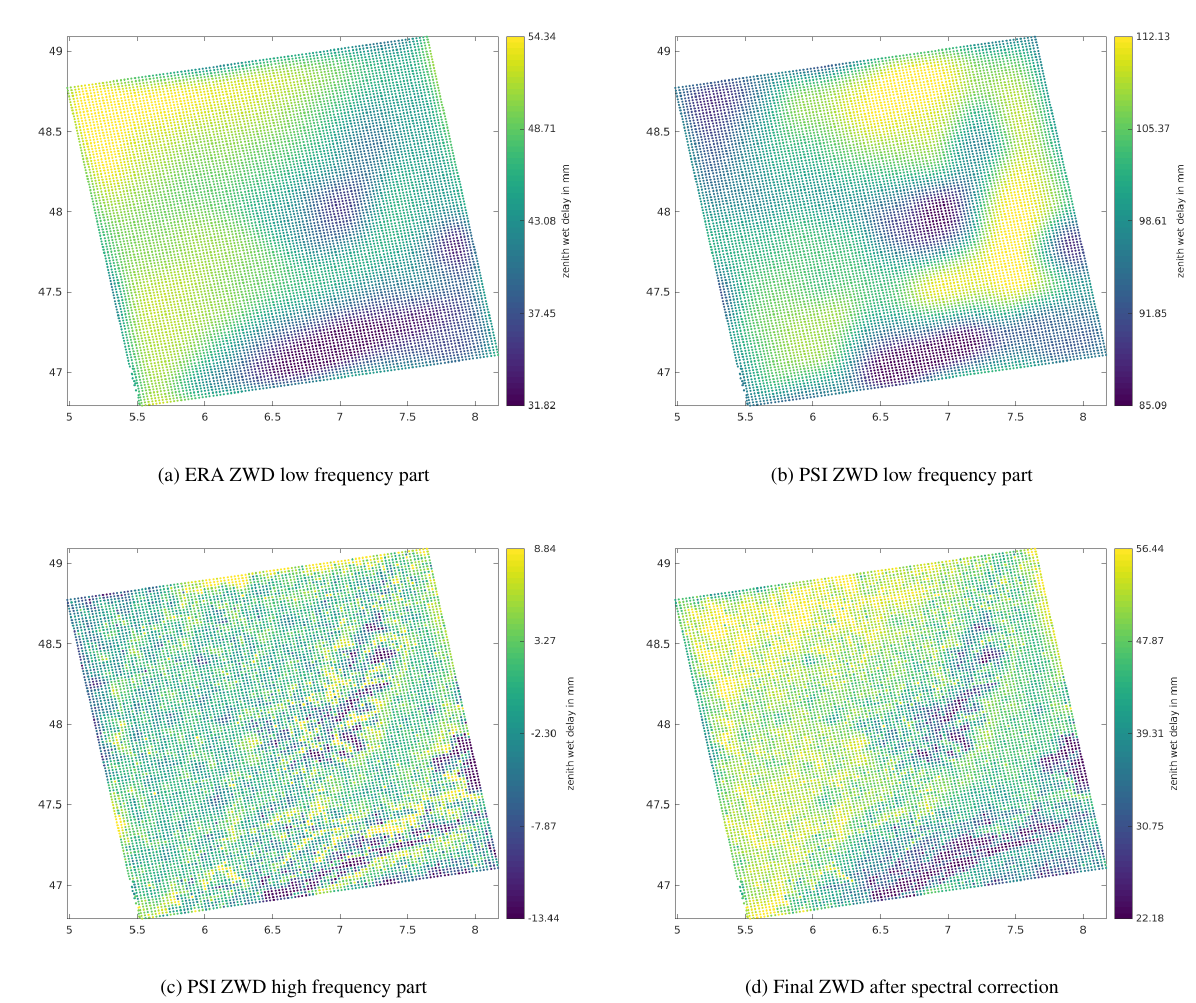
Figure 4. Different frequency parts of the dataset of 2016/02/03 17:24UTC are shown: (a) and (b) show the low frequency part of the ERA5 and SAR data, (c) displays the high frequency part of the PSI data and (d) is the final product using (a) and (c).